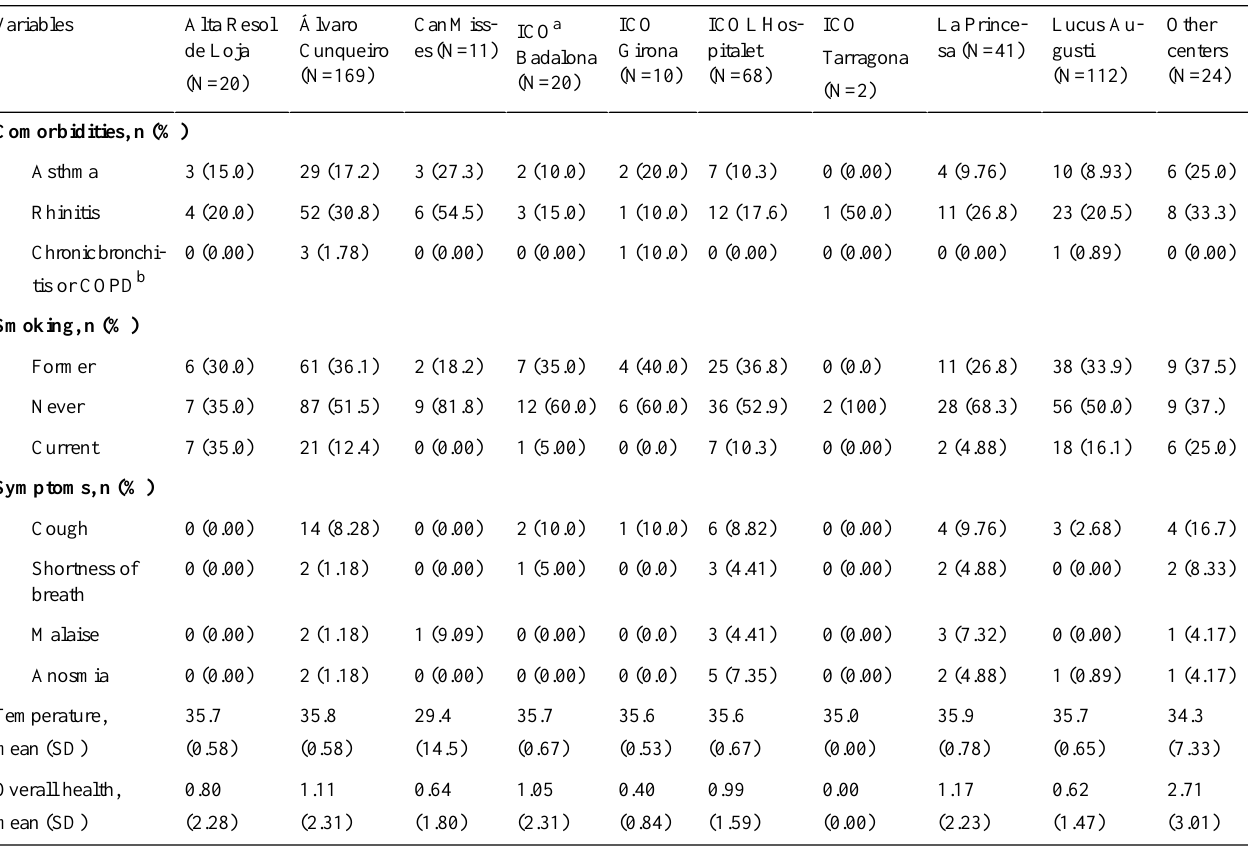
Table 3. Distribution of HEpiTracker variables by hospital.